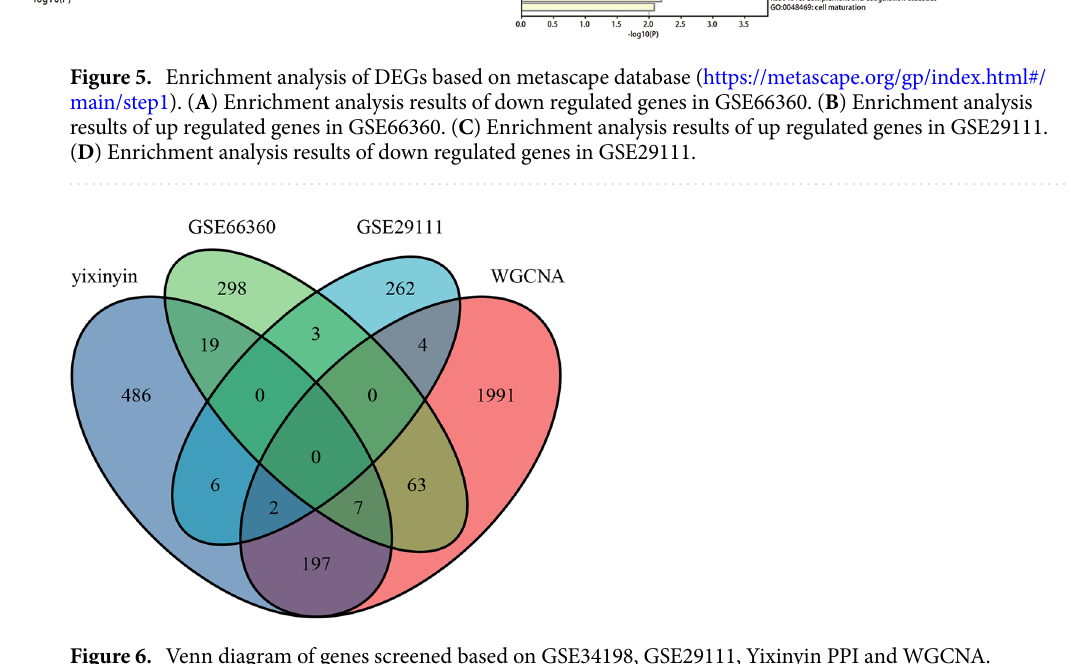
Figure 6. Venn diagram of genes screened based on GSE34198, GSE29111, Yixinyin PPI and WGCNA.